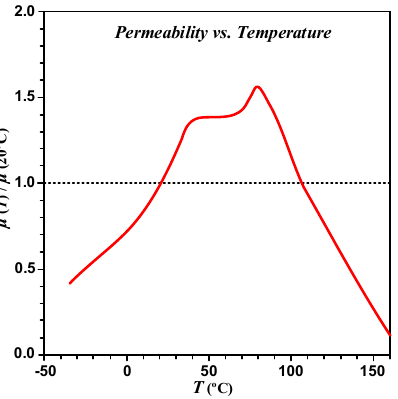
Figure 11. Variation of the initial permeability with temperature. Table 4. Working-coil parameter value for all-metal IH system. Parameter Ferromagnetic Pot